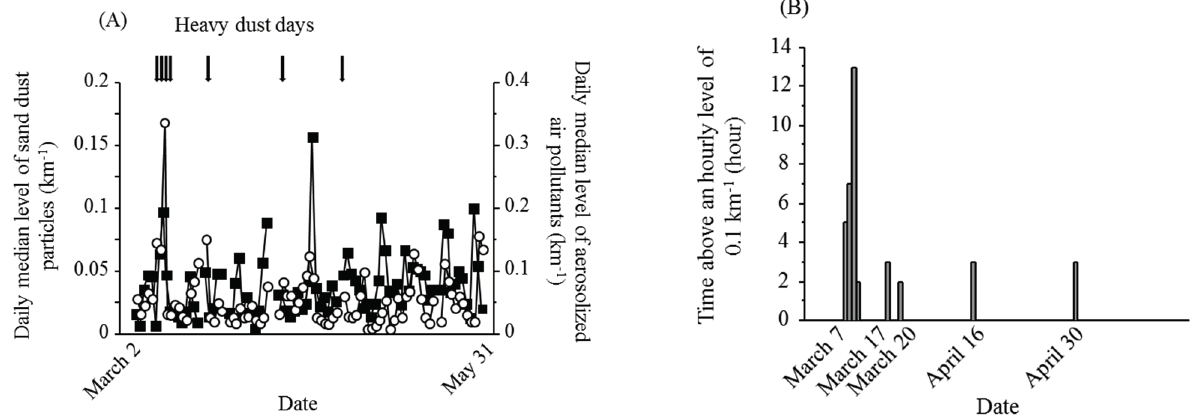
Figure 2. Sand dust particle and aerosolized air pollutant levels ( A ) Daily median levels of sand dust particles (open circles) and aerosolized air pollutants (closed squares). A heavy dust day was defined as an hourly sand dust particle level >0.1 km − 1 using light detection and ranging data. Arrows indicate heavy dust days; ( B ) The time above 0.1 km − 1 was based on hourly levels. Eight heavy dust days, 7–10 March, 17 March, 20 March, 6 April, and 30 April, occurred during the study